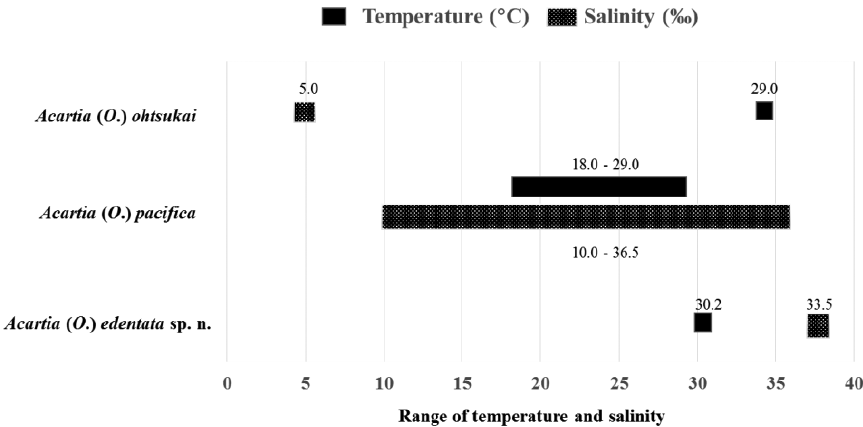
Figure 7. Ranges of salinity and temperature of three Acartia species occurring in the tropical and sub- tropical zones of the Pacific and Indian